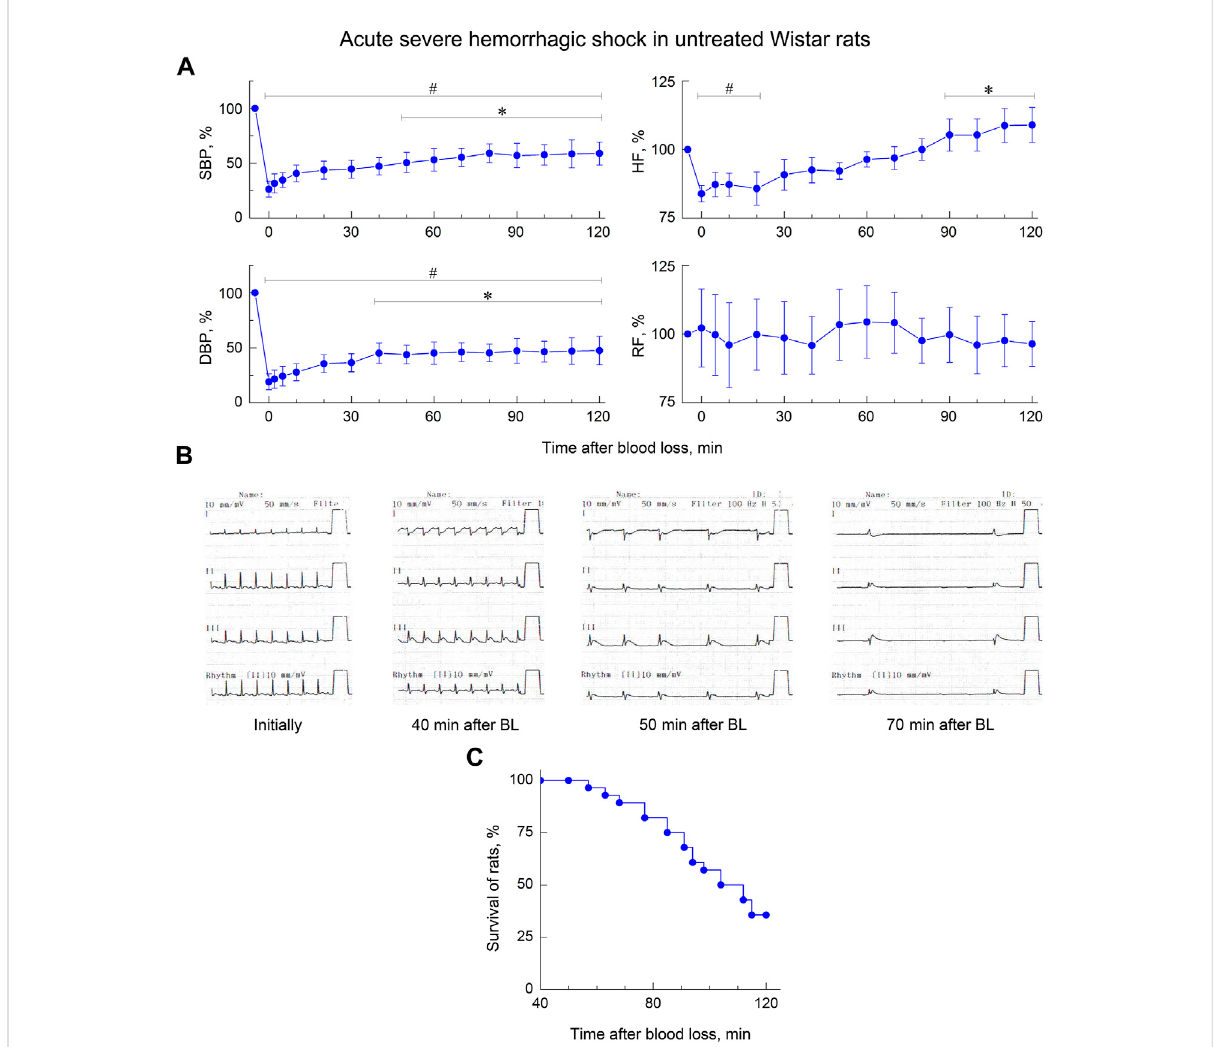
FIGURE 2 Early stage of acute severe hemorrhagic shock in untreated anesthetized Wistar rats. (A) Dynamics of indicators of systolic and diastolic blood pressure (SBP and DBP), heart frequency (HF) and respiratory frequency (RF). Data are normalized to the original values of indicators of animals and presented as percentage. Graphical deviations correspond to SD (n = 10 – 28 per point). # - signi fi cantly different vs. original value of indicator (SBP: p < 0.00001, p < 0.00001, p < 0.00001, p = 0.00002, p = 0.00005, p = 0.00007, p = 0.00023, p = 0.00049, p = 0.00072, p = 0.00148, p = 0.00136, p = 0.00219, p = 0.00165, p = 0.00374, p = 0.00531, respectively; DBP: p < 0.00001, p < 0.00001, p < 0.00001, p < 0.00001, p = 0.00003, p = 0.00008, p = 0.00027, p = 0.00019, p = 0.00076, p = 0.00061, p = 0.00052, p = 0.00263, p = 0.00175, p = 0.00360, p = 0.00574,